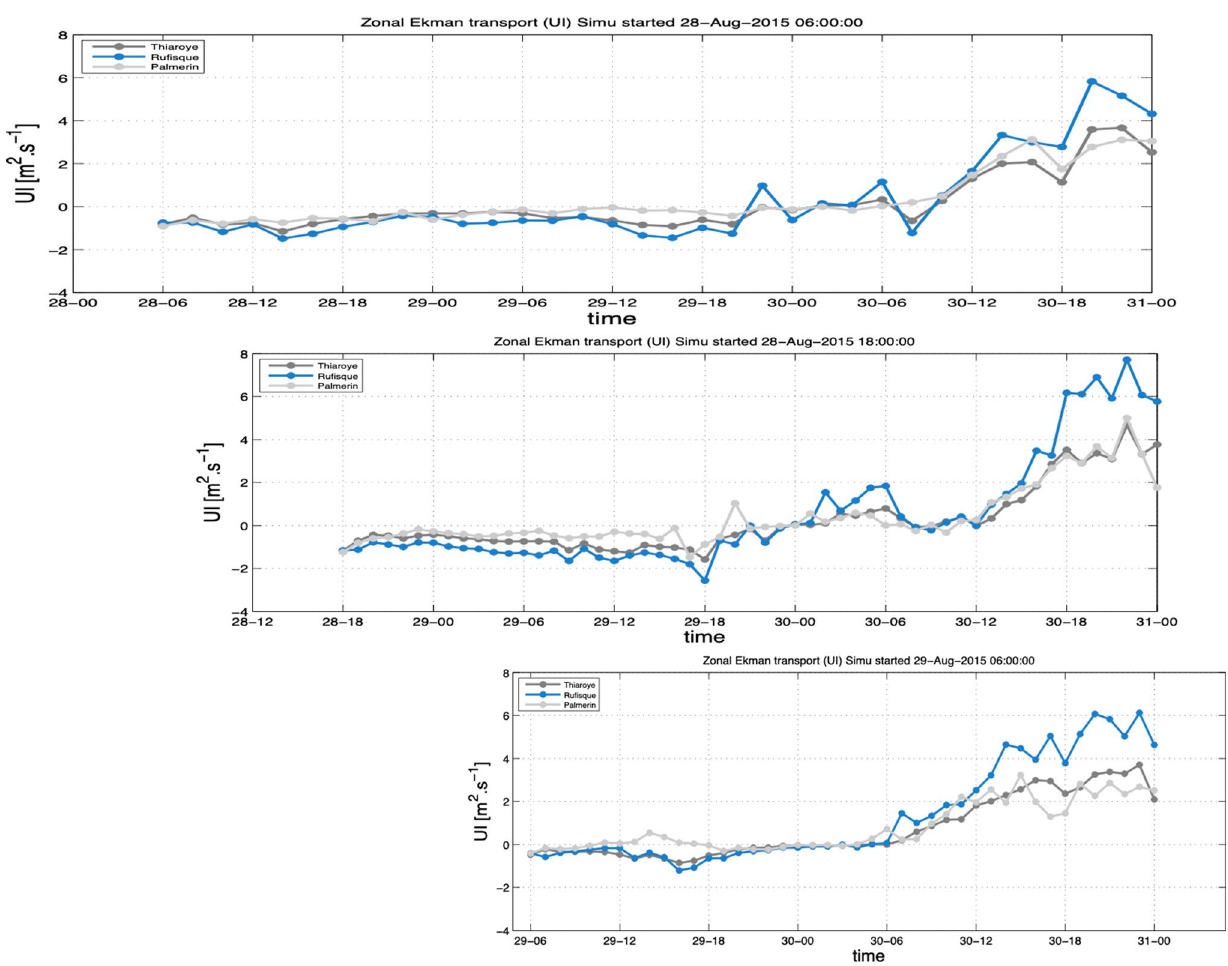
Fig. 7 Computed Zonal Ekman transport (m 3 · s −1 ·m −1 ) at grid-point locations near Palmerin, Rufisque, and Thiaroye (see Fig.